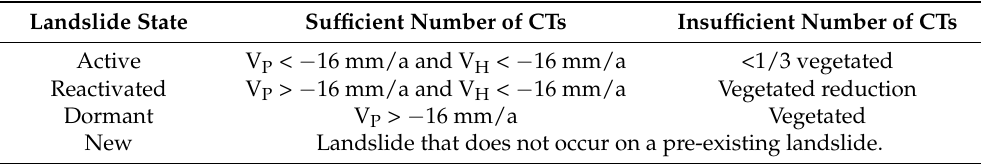
Figure 11. Deformation rate in the slope direction and severely deformed slope. ( a ) Deformation from 2003 to 2006; ( b ) deformation from 2008 to 2010; ( c ) deformation from 2014 to 2020; ( d ) severely deformed landslide; ( e ) position of water seepage. Table 4. Classification criteria of landslide activity in this